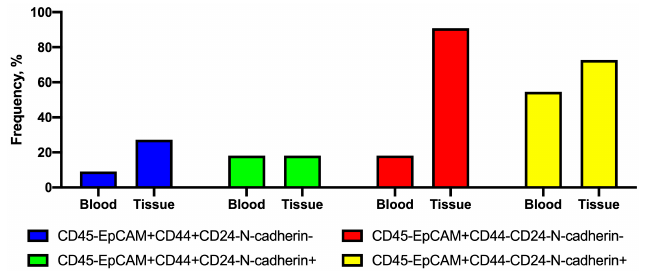
Figure 3. Frequency of tumor cells with different CD44 and N ‐ cadherin expression in primary tumors and peripheral blood.